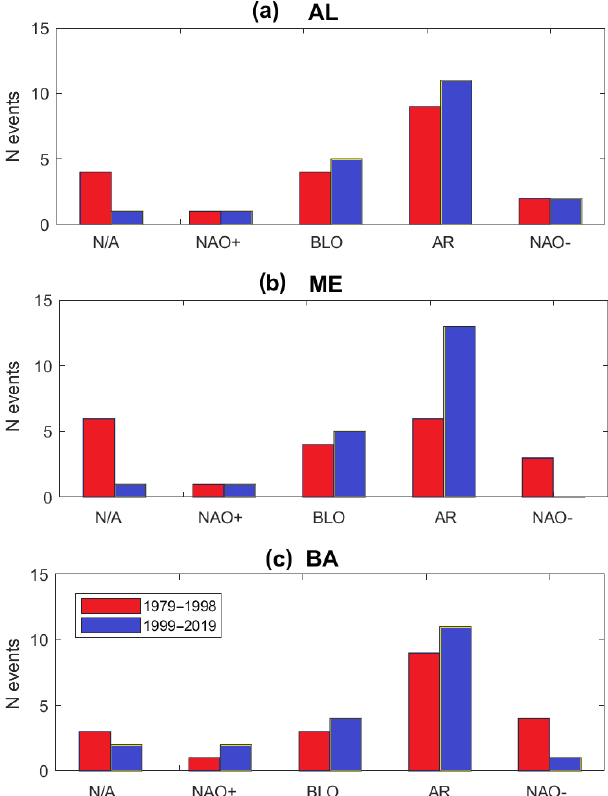
Figure 10. Histograms of weather regimes during the days of maximum snowfalls. N/A: nonattributable; NAO + : North Atlantic Oscillation positive phase; BLO: blocking; AR: Atlantic Ridge; NAO − : North Atlantic Oscillation negative phase. (a) Albania (AL), (b) Montenegro (ME), (c) Bosnia (BA). Red bars correspond to 1979–1998 and blue ones to